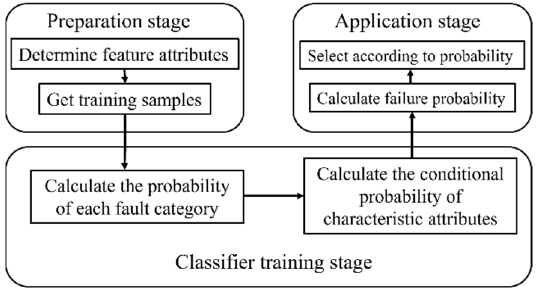
Figure 4. Flow chart of the Naive Bayes algorithm.